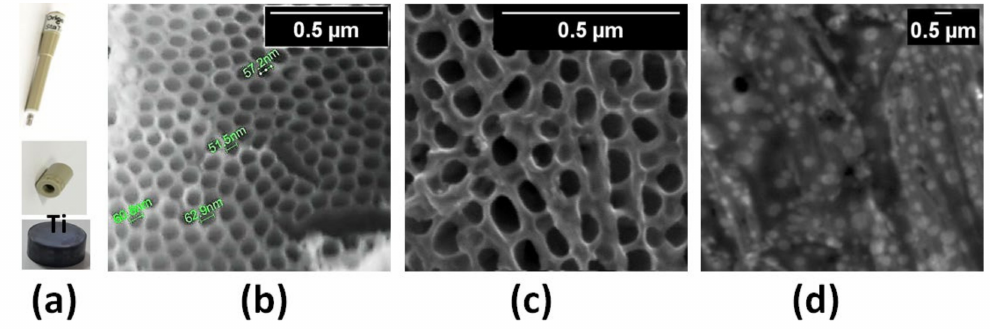
Figure 2. Origalys system with Ti electrode used in this study ( a ) and top view SEM images after each modification step: TiNT ( b ), TiNT GO ( c ), TiNT GO antibody ( d